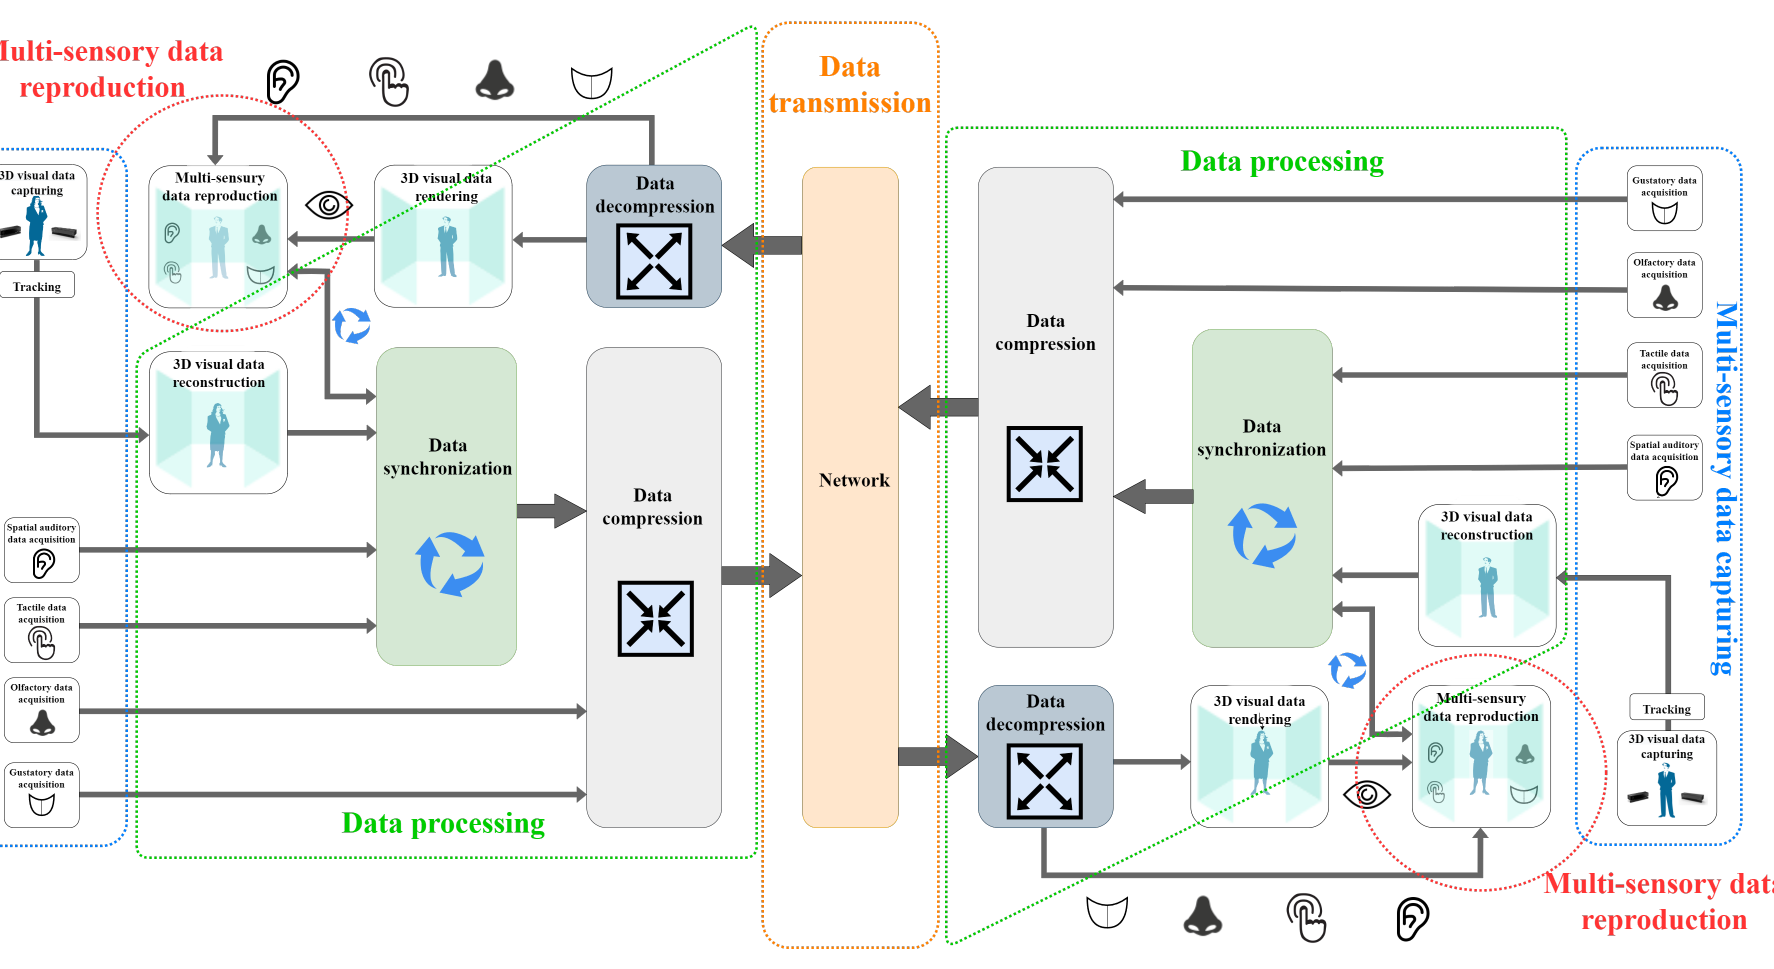
Figure 3. HTC system